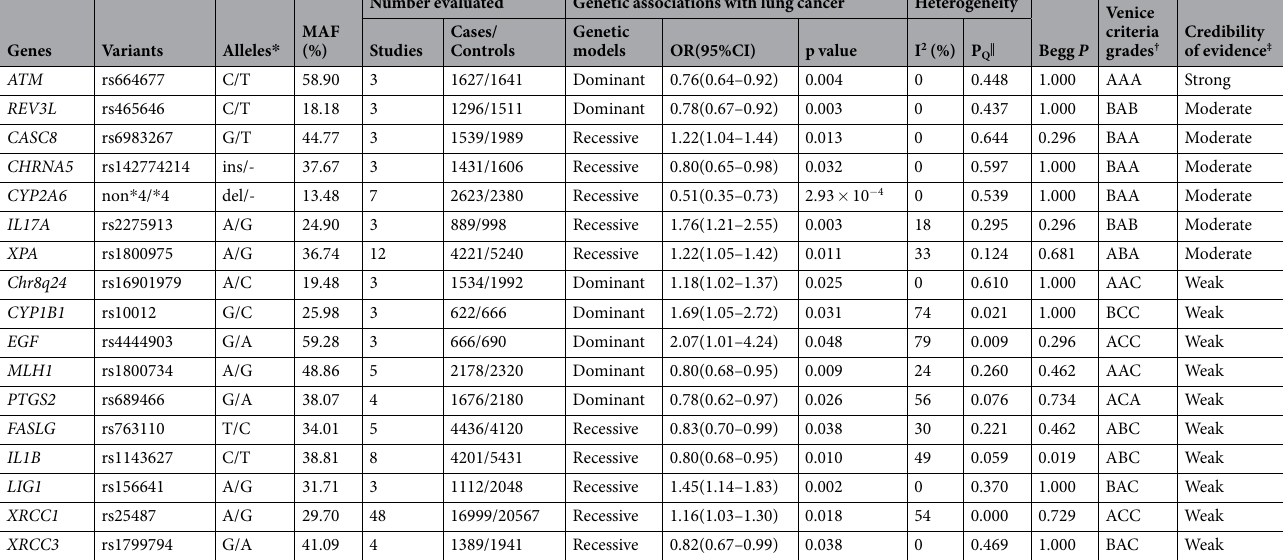
Table 2. Genetic variants with significant associations with lung cancer risk under a dominant or recessive genetic model. MAF = minor allele frequency in controls. OR = odds ratio; 95% CI = 95% confidence interval. chr = chromosome. ins = insertion. del = deletion. bp = base pair. * Minor alleles/major alleles (per Caucasian); major alleles were treated as reference alleles in the analyses; Dominant model, summary OR was estimated for subjects who carry one or two minor alleles. Recessive model, summary OR was estimated for subjects have homozygous of the minor alleles. ǁ P value of the test for between-study heterogeneity. † Venice criteria grades are for amount of evidence, replication of the association, and protection from bias; one rare variant was not scored for amount of evidence ( × ). ‡ Credibility of evidence is categorized as “strong”, “moderate”, or “weak” for association with lung cancer